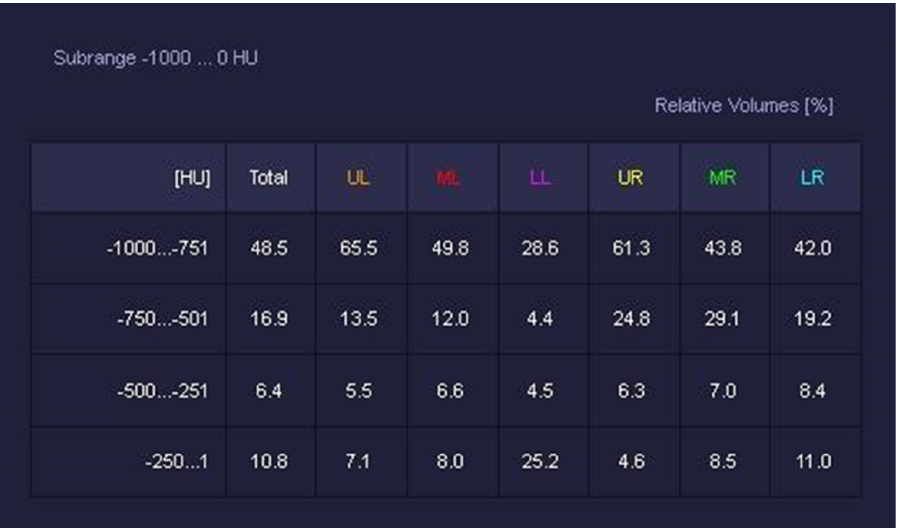
Figure 6. CT Pulmo 3D: thresholds and volumes. This figure shows the HU thresholds and relative volumes per lobe.